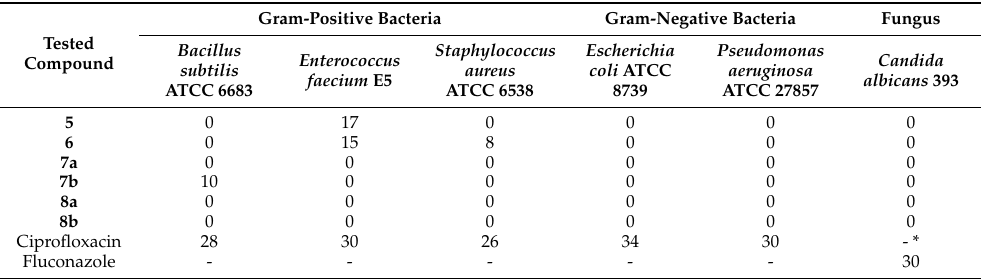
Table 2. Results of the qualitative analysis of the antimicrobial effect of compounds 5 – 8 tested at 5000 µ g/mL, using an adapted disk diffusion method (diameters of growth inhibition zones were measured in